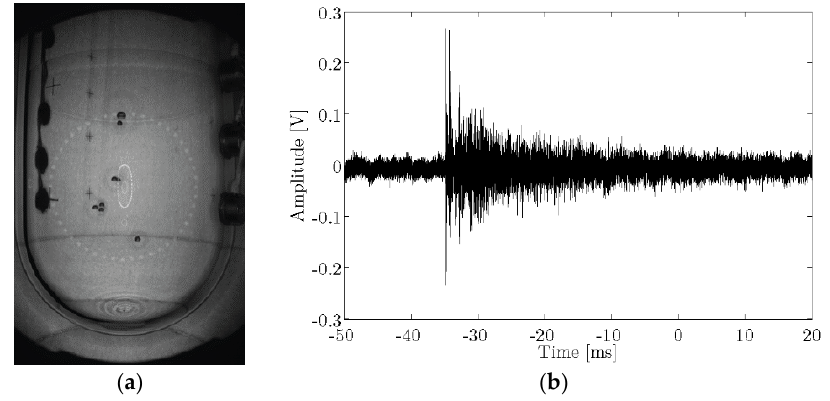
Figure 1. ( a ) image of PICO-60 during a multi-bubble neutron event due to multiple scattering inside the detector [2]; ( b ) typical acoustic signal recorded by a PICO acoustic sensor.